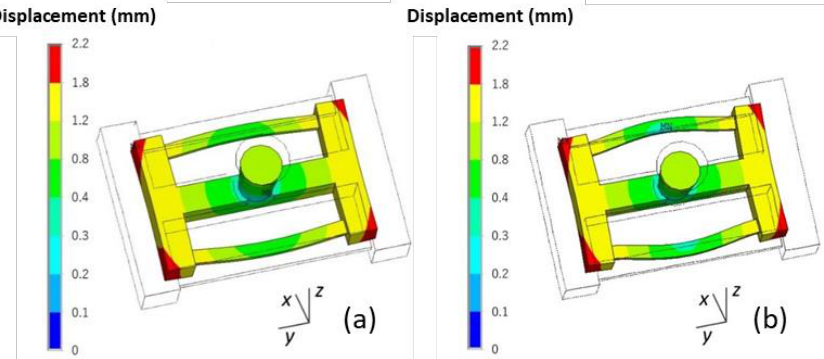
Figure 19. Comparison of the deformation (equivalent displacement and deformed geometry) of casting at shakeout using (a) the skeletal and (b) the traditional sand mold, magnification ×20.